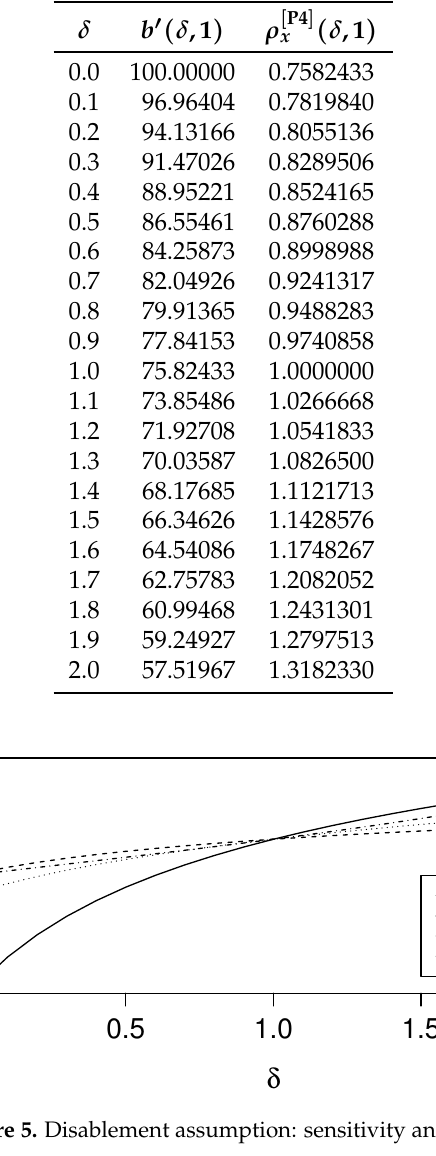
Figure 5. Disablement assumption: sensitivity